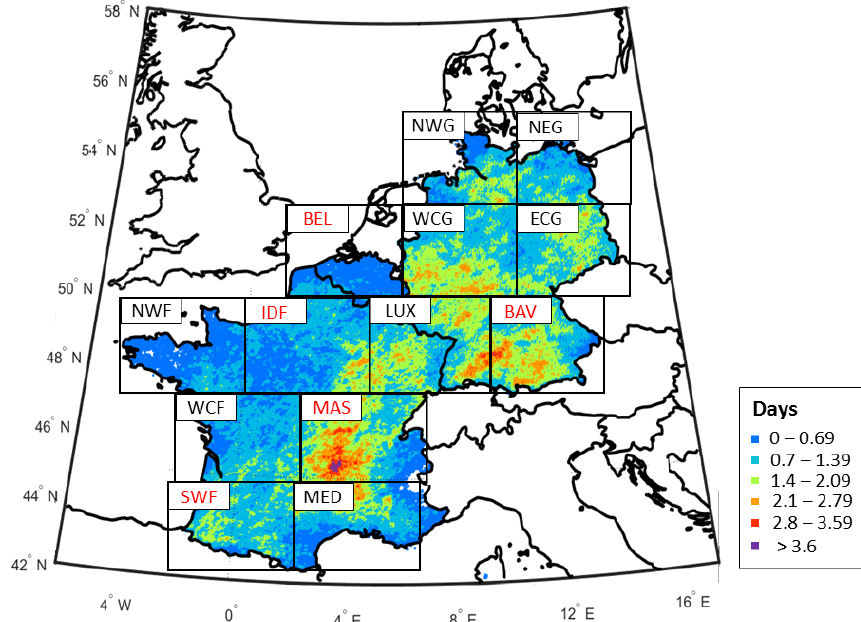
Figure 3. Annual radar-derived hail frequencies for 1 × 1km 2 grid points in France, Germany, Belgium and Luxembourg between 2005 and 2014. Squares represent boundaries of subdomains further investigated in this study (see Sect. 4.3 for further details). The subdomains were named as follow: NWG (northwest Germany), NEG (northeast Germany), BEL (Belgium), WCG (west central Germany), ECG (east central Germany), NWF (northwest France), IDF (Île-de-France), LUX (Luxembourg), BAV (Bavaria), WCF (west central France), MAS (Massif Central), SWF (southwest France), MED (Mediterranean). Special emphasis is given for subdomains written in red.